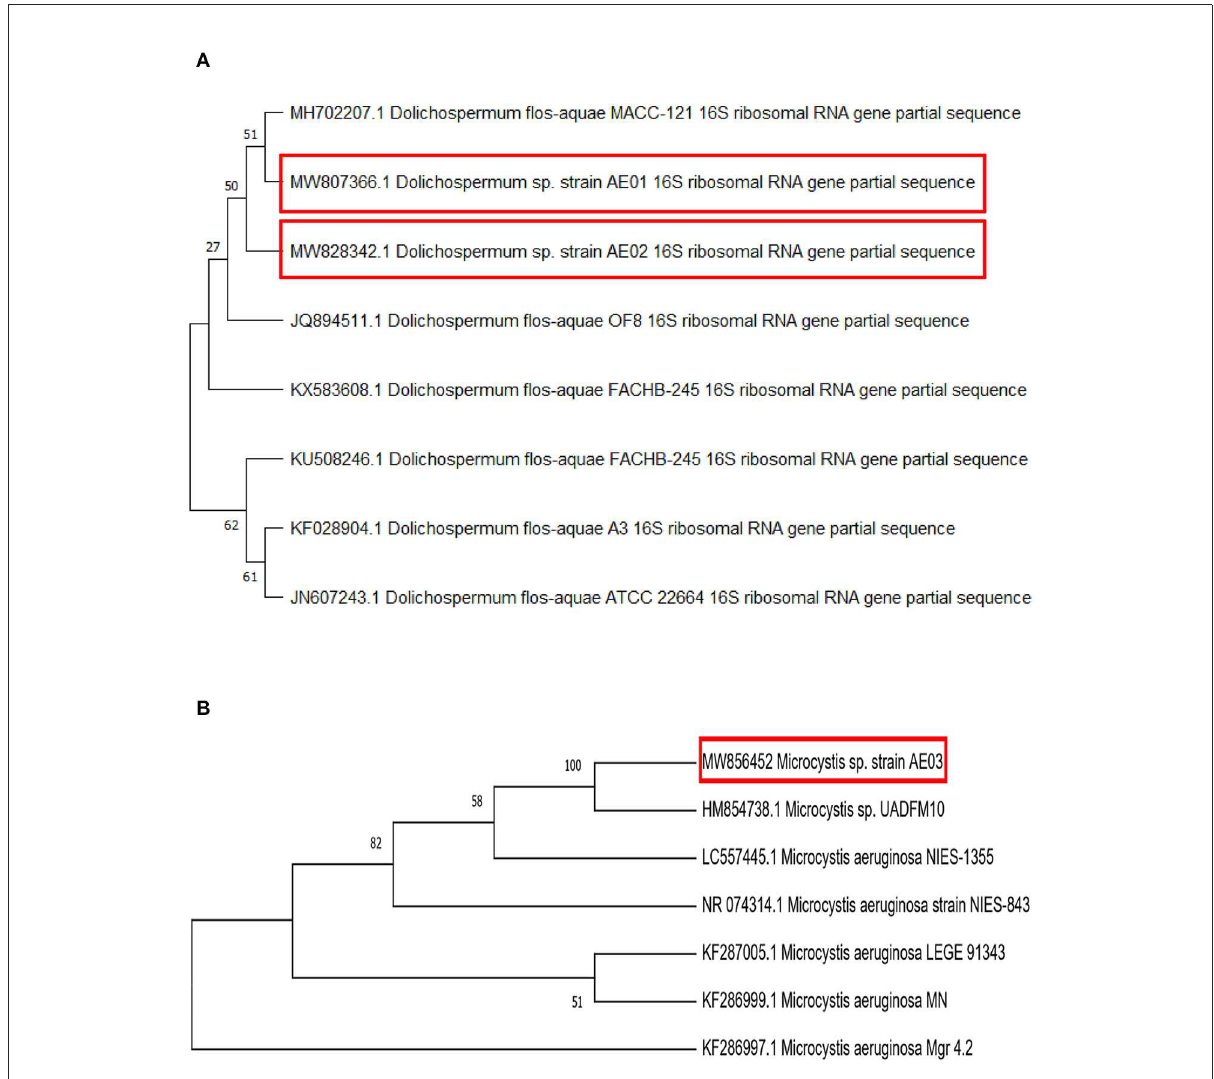
FIGURE3 A Cladogram, using the Neighbor-Joining method of selected 16S rDNA nucleotide sequences of (A) Dolichospermum sp. strain AE02, and AE01 (B) Microcystis sp. strain AE03. Bootstrap replicates 500, constructed with the MEGA X program. The evolutionary distances were computed using the Jukes-Cantor